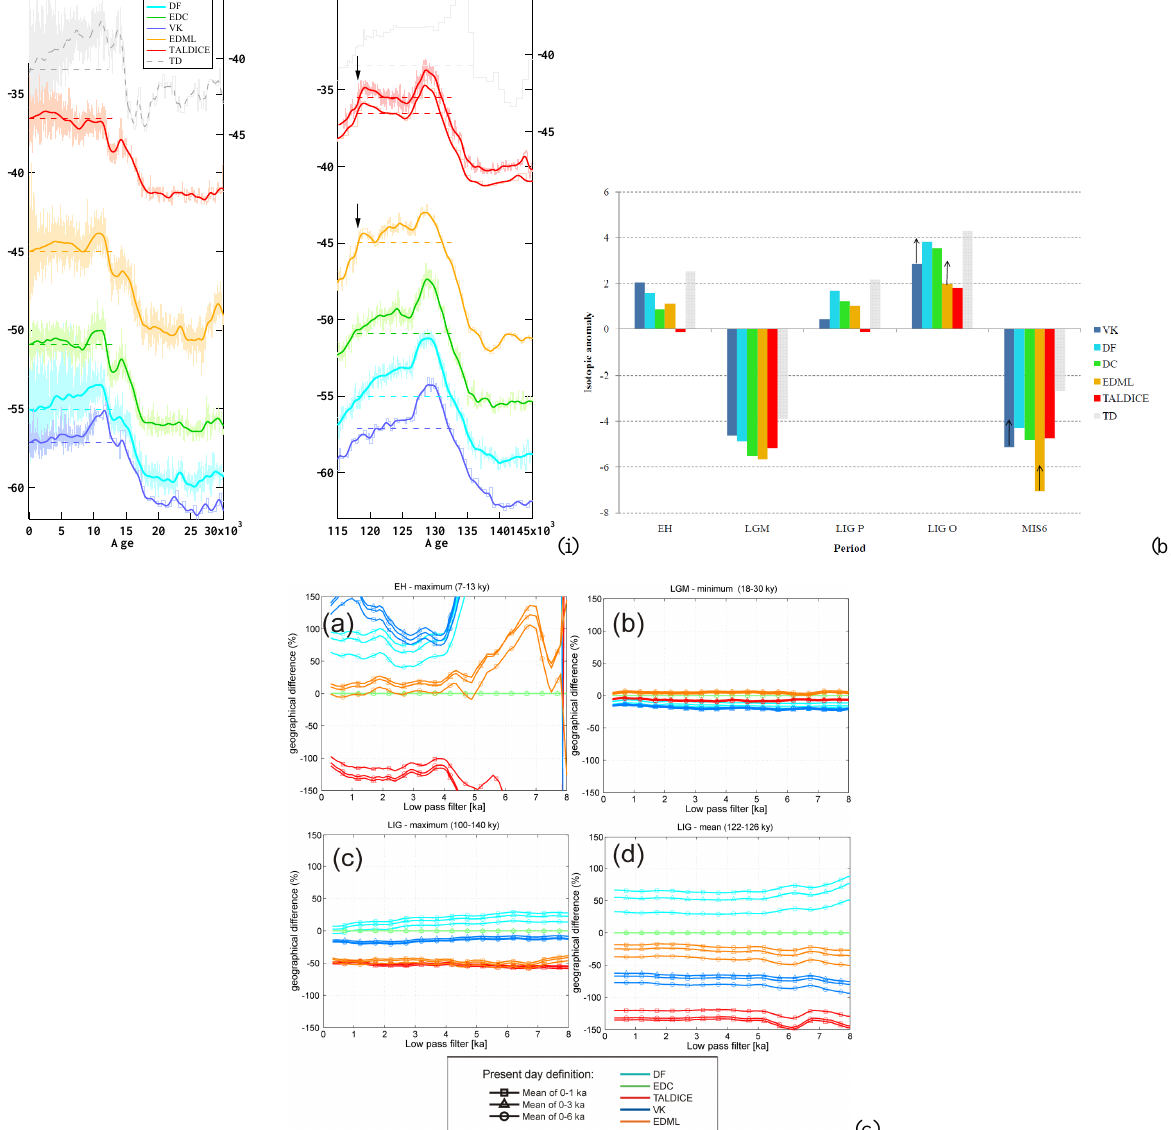
Fig. 4. (i) Original water stable isotope records available from all ice core sites (‰), displayed on the EDC3 age scale for the current (left panel) and last (right panel) interglacial periods with the exception of TD on its initial age scale (grey, left vertical axis with the same vertical scaling as for the right axis). All raw data (thin lines) and 5 point binomial filter 200 year re-sampled data are displayed (bold lines). Two series of measurements are available for the last interglacial period for TALDICE: bag samples (1m) and fine samples (0.05m). The high resolution data have been artificially shifted by 1‰ for readability. The black arrows display the abrupt TALDICE and EDML δ 18 O decrease observed at ∼ 118kyr. (ii) Based on the smoothed records displayed in Fig. 4a, comparison of the δ 18 O anomalies (‰ between the last millennium (reference), the early Holocene EH (warmest millennium between 7 and 13kyr), the Last Glacial Maximum LGM (coldest millennium between 18 and 30kyr), the optimum of the last interglacial (LIG) O (warmest millennium between 100 and 140kyr), the plateau of the last interglacial LIG P (mean conditions between 122 and 126kyr) and the previous glacial maximum MIS6 (coldest millennium between 130 and 150kyr). The Vostok and EDML records are affected by changes in upstream ice origin leading to a decreasing δ 18 O trend clearly visible for LIG O and MIS6. The published estimates for the upstream effects are displayed as vertical arrows, (without taking into account changes in ice sheet elevation with time). The same analyses were conducted on TD despite chronological uncertainties (grey bars). (iii) Sensitivity analysis of the δ 18 O geographical anomalies: tests conducted with respect to the definition of the “present-day” (0– 1kyr, 0–3kyr or 0–6kyr mean, different symbols) and with respect to the smoothing length applied to the data (0.2 to 8ka, horizontal axis). Percentage differences are relative to EDC and displayed for each time interval – (a) Early Holocene, (b) LGM, (c) LIG maximum and (d) LIG mean. For clarity, different y-axis scales are used for the different panels. Note that the Vostok and EDML record are affected by changes in upstream ice origin leading to a decreasing δ 18 O trend for the oldest time